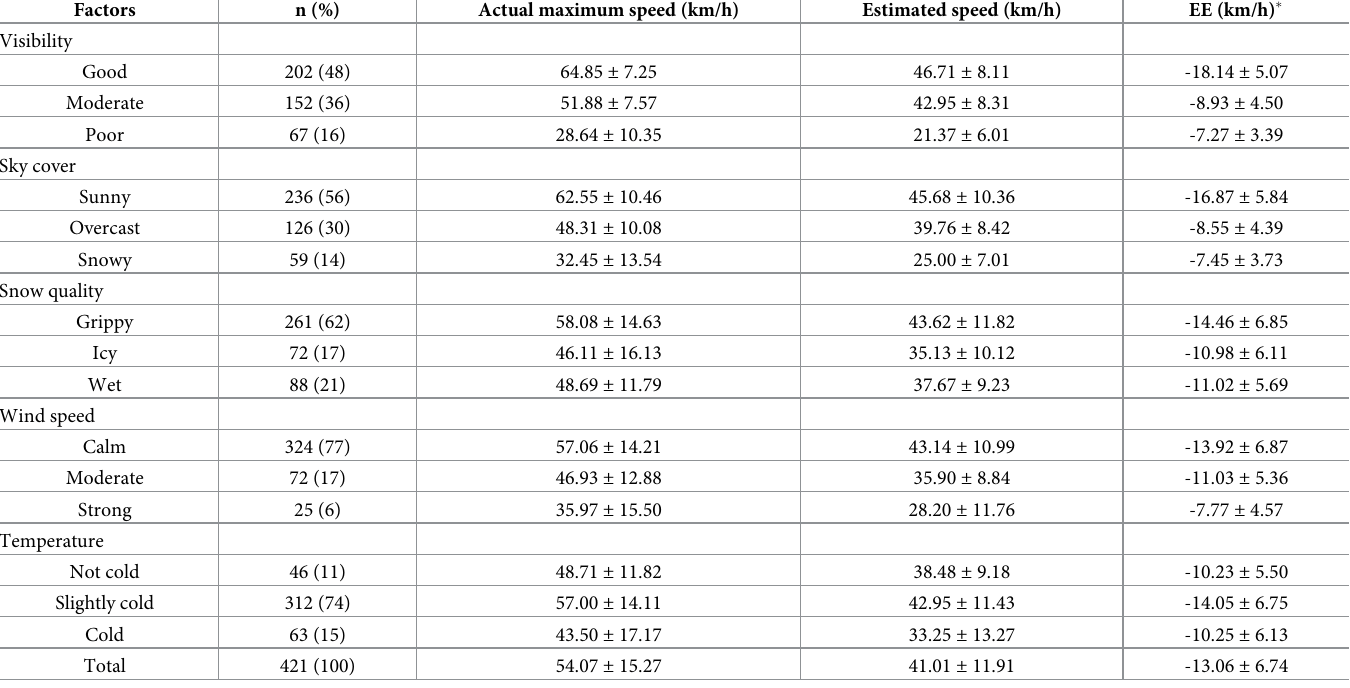
Table 1. Environmental factors profile and mean values ( ± SD) of actual maximum speeds, estimated speeds and EEs with regard to visibility, sky cover, snow qual- ity, wind speed and